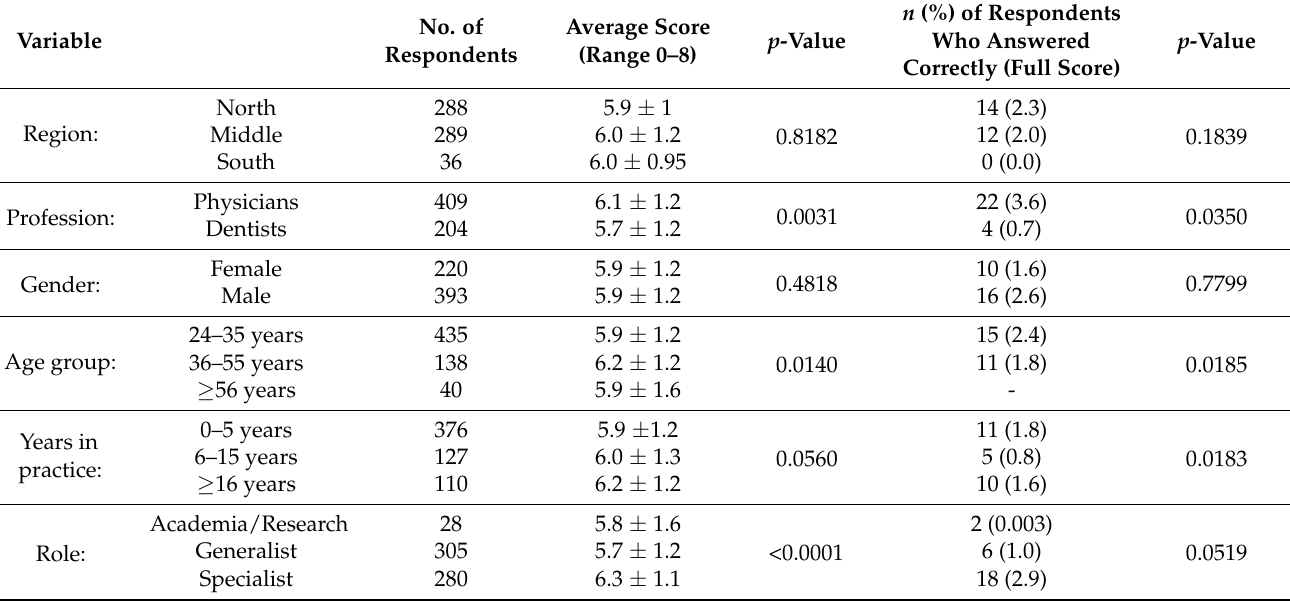
Table 3. Predictors of actual knowledge scores among